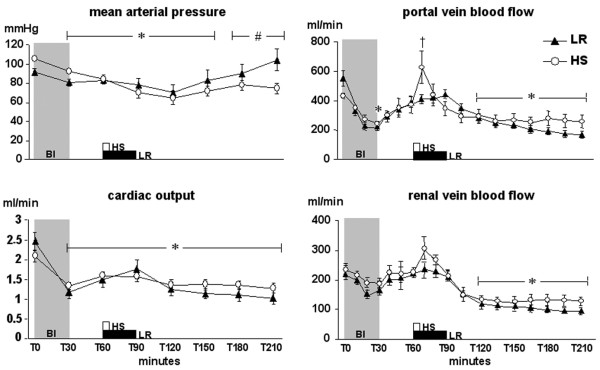
Mean arterial pressure (mmHg, mean ± standard error of the mean (SEM)), cardiac output (l/minute, mean ± SEM), portal vein blood flow (ml/minute, mean ± SEM) and renal vein blood flow (ml/minute, mean ± SEM) during the experimental protocol. LR group received lactated Ringer's solution 32 ml/kg over 30 minutes, n = 7; HS group received 7.5% hypertonic saline solution 4 ml/kg over 5 minutes, n = 8. *p < 0.05 versus T0, both groups; †p < 0.05 versus HS; # HS, p < 0.05 versus T0. BI, bacterial infusion.